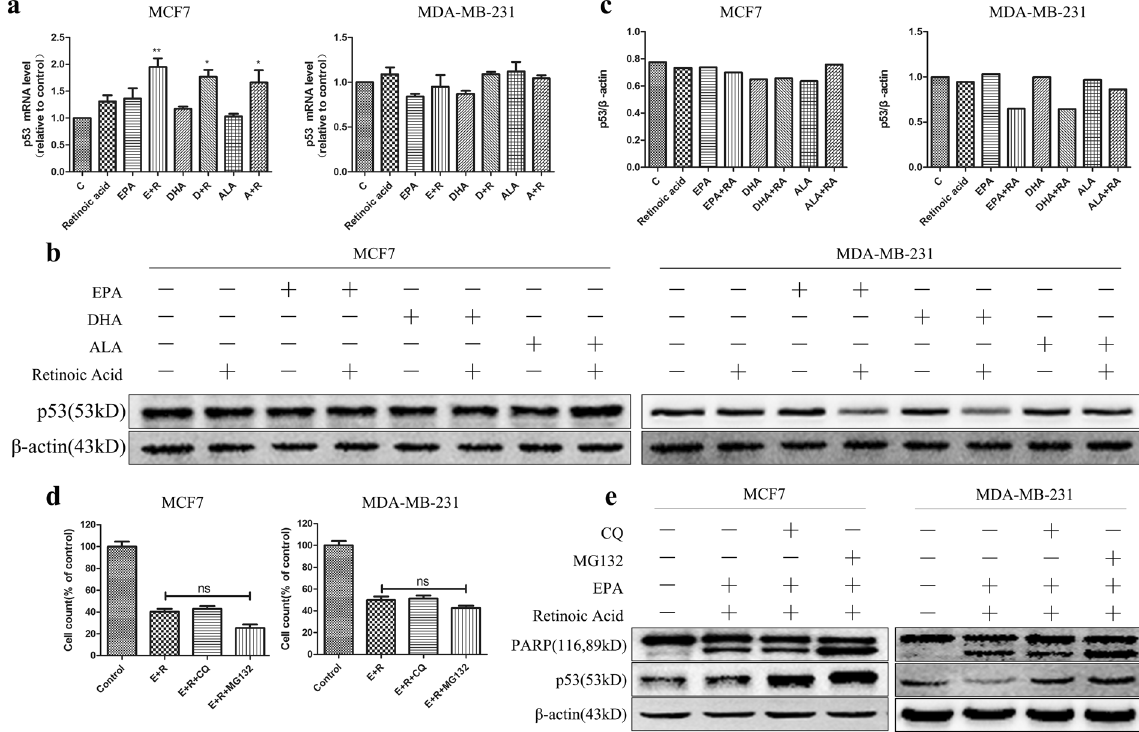
Figure 4. p53 and Cell apoptosis. MCF7 and MDA-MB-231 cells were treated with 80 μ M ω - 3 FFAs, 20 μ M ATRA alone or in combination for 48 h. ( a ) Relative expression of p53 was determined by Q-PCR. ( b ) The expression of p53 protein. β -Actin was used as an internal control. ( c ) Quantification of p53 protein level (relative to β -Actin). MCF7 and MDA-MB-231 cells were treated with 80 μ M ω -3 FFAs and, 20 μ M ATRA alone or in combination in the absence or presence of proteasome inhibitor MG132 or lysosome inhibitor CQ. ( d ) Cell counting assays. ( e ) The expression of PARP and p53 protein. β -Actin was used as an internal control. Values represent the mean ± SD (n = 3). * P < 0.05; ** P < 0.01; *** P <